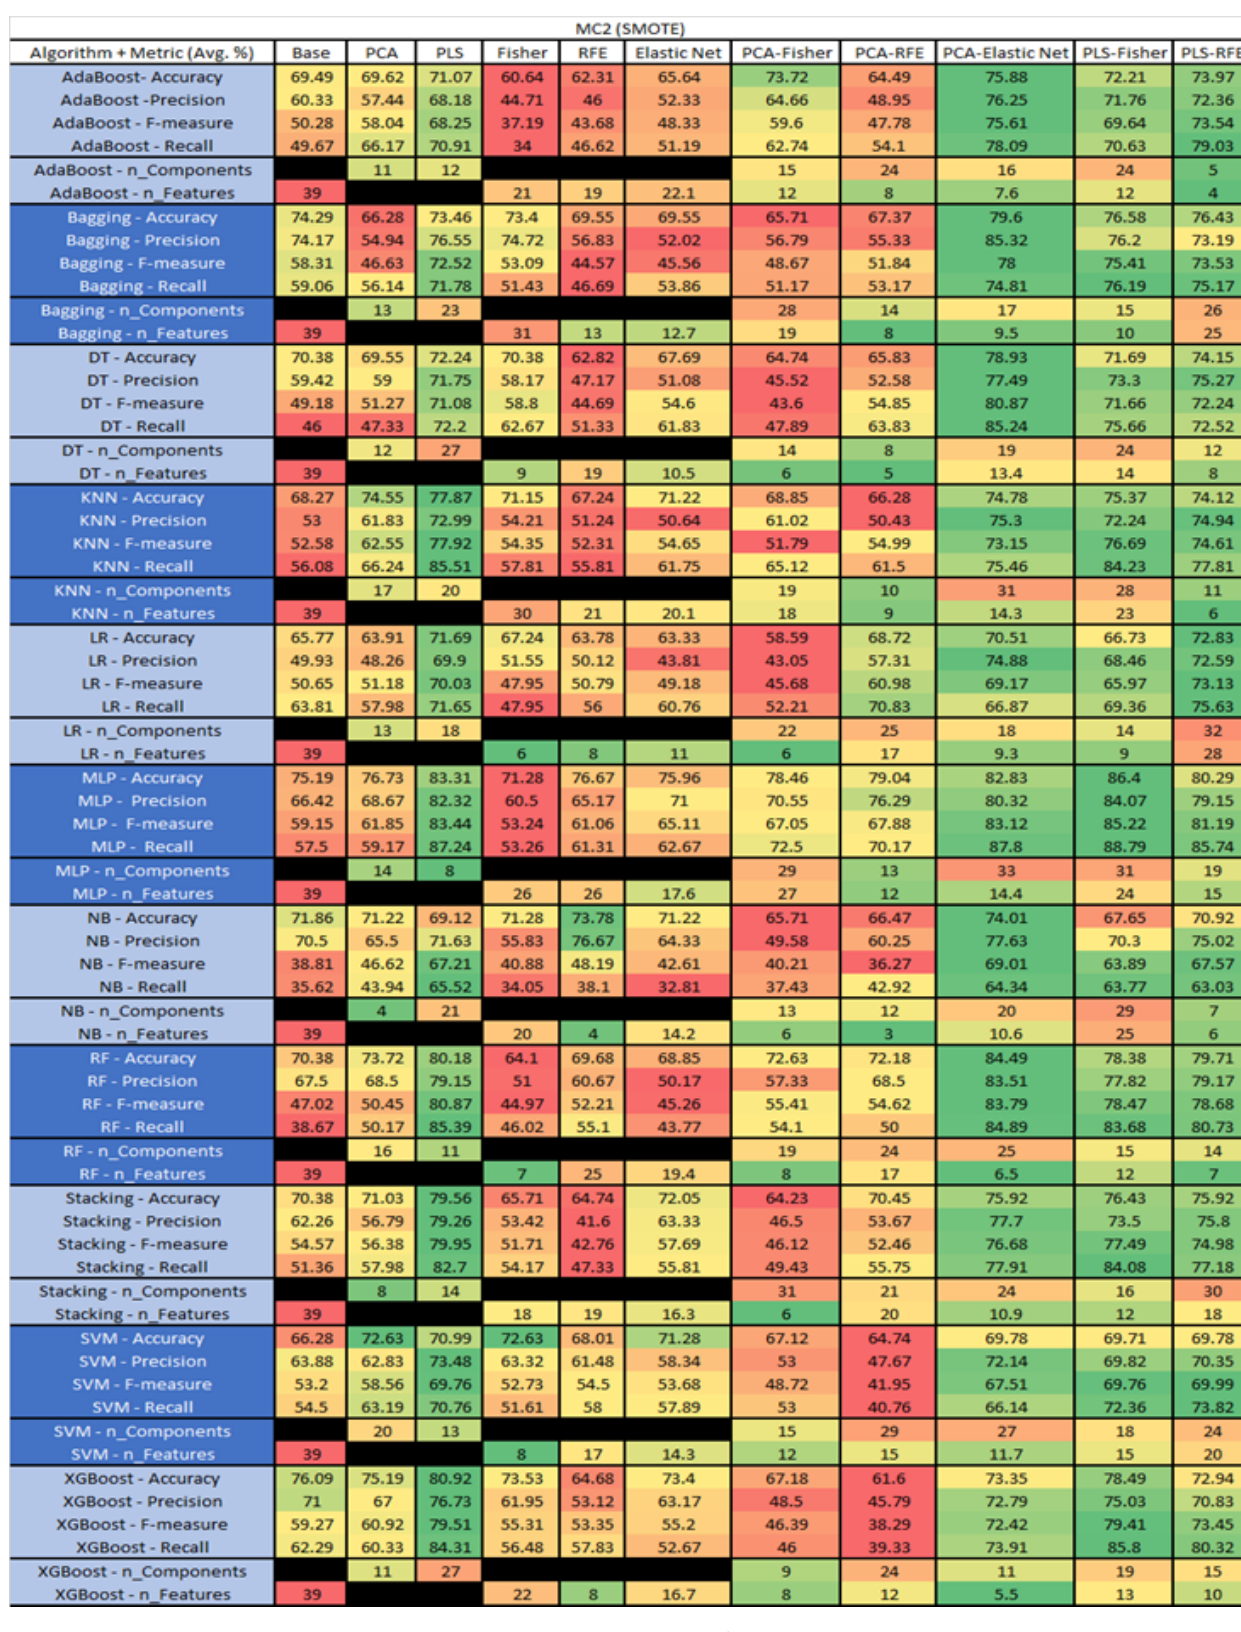
Figure 37. MC2 SMOTE NASA MDP Results Data